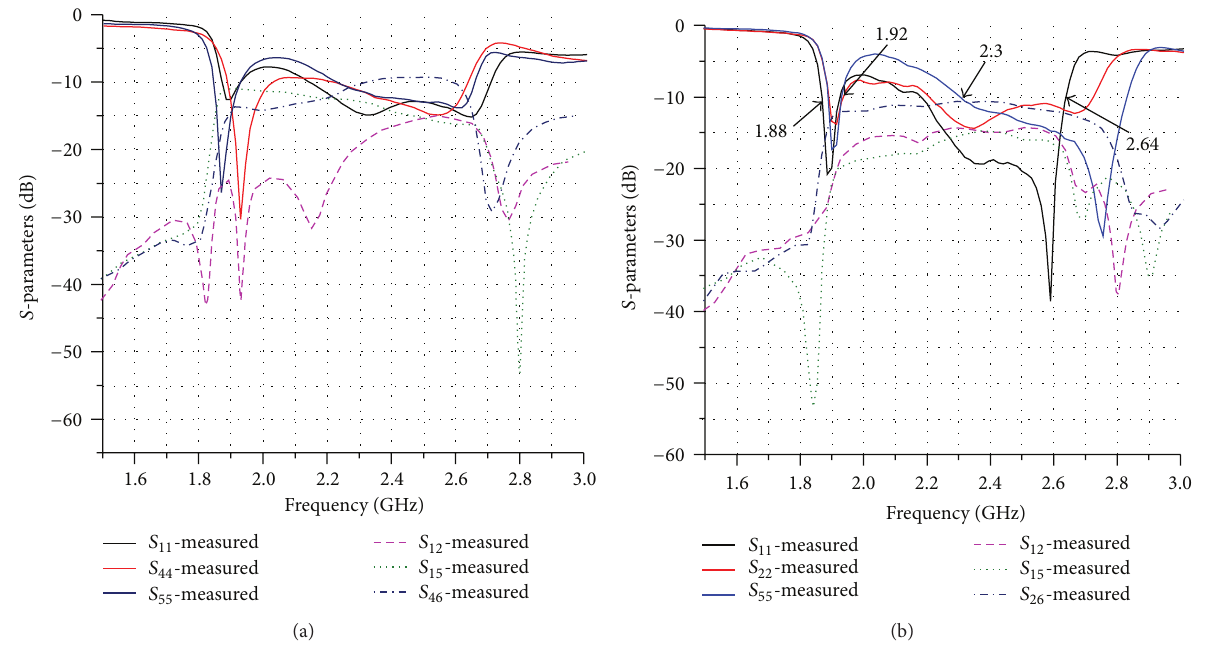
Figure 12: The 𝑆 -parameters of six-element MIMO system.